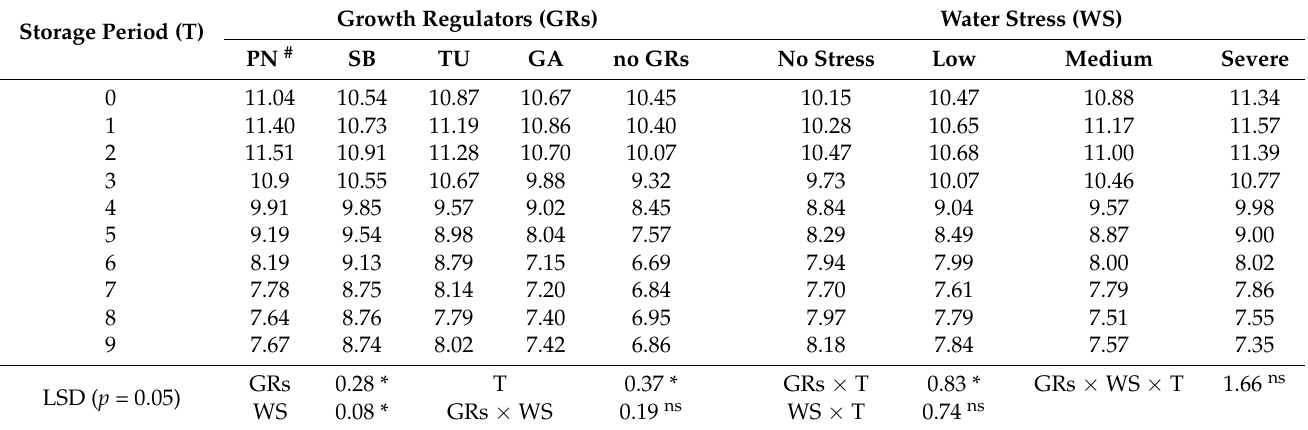
Table 1. Changes in the dry matter (%) of onion bulbs kept for long-term storage (9 months) under different GRs and water stress